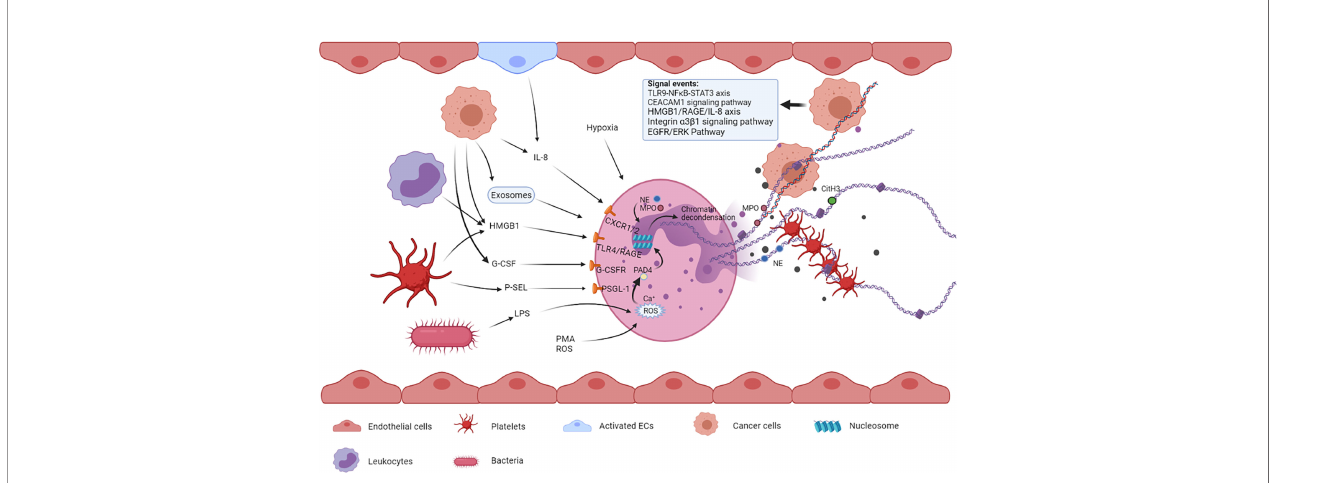
FIGURE 1 | Multiple cells such as tumor cells, platelets, bacterial cells, and endothelial cells and their released factors are involved in NETosis. These factors from different types of cells can bind to their respective receptors on neutrophils, leading to NET formation. The released NETs are composed of a DNA skeleton and decorated granular and cytosolic proteins such as citH3, NE, and MPO. Thereafter, they can further activate and capture platelets, leading to venous thromboembolism. NETs can also entrap circulating tumor cells, promoting extravasation and